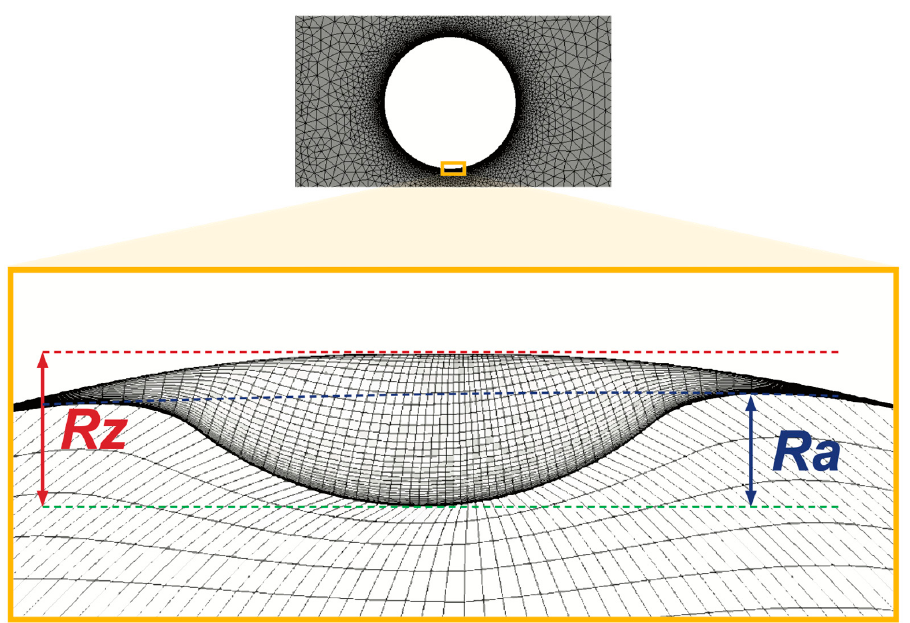
Figure 4. The simulated rough surface and surface roughness parameters ( R a and R z ). Table 4. The considered conditions of the heat convection experiments.